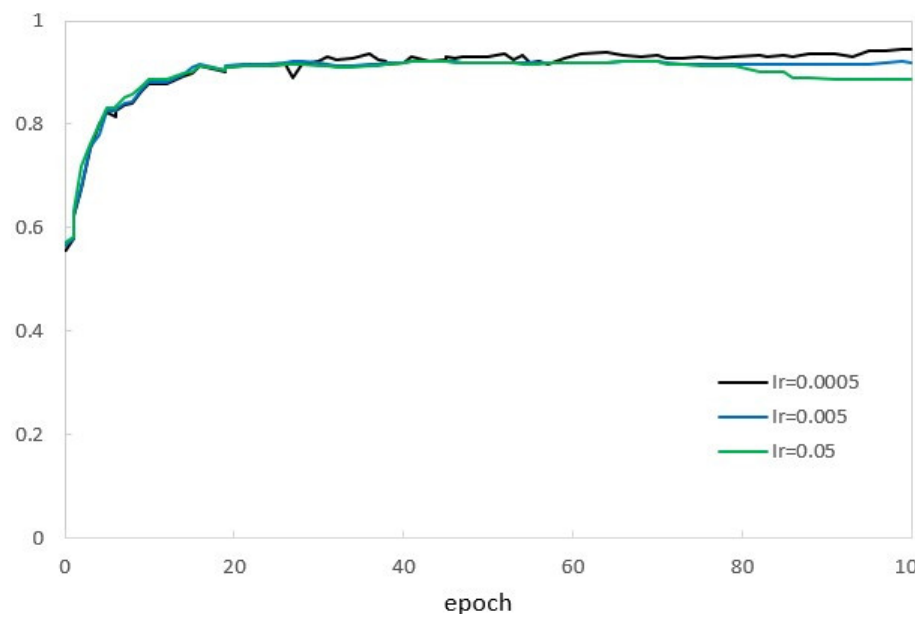
Figure 8. Relationship between model accuracy, learning rate, and iteration times.